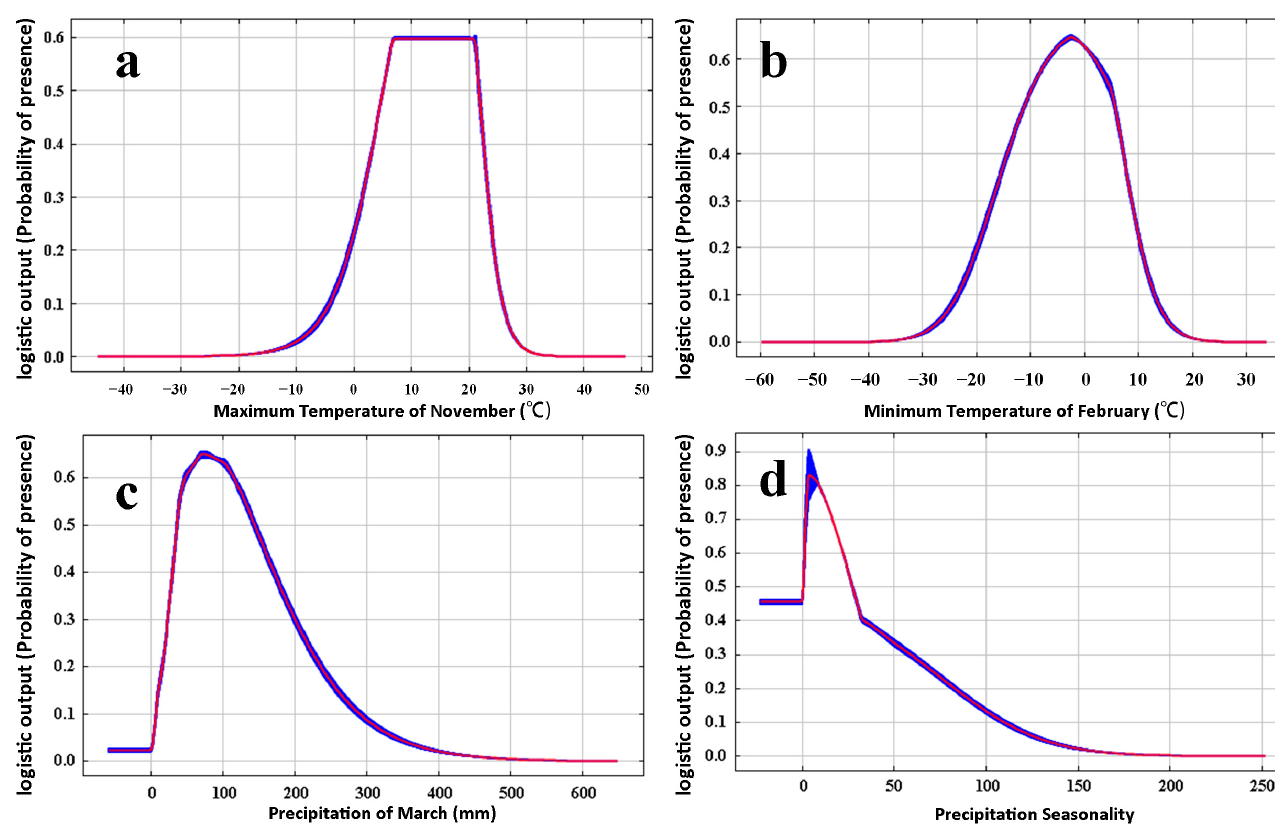
Figure 5. Response curves of M . destructor to various environmental factors in the MaxEnt model. ( a ) Maximum temperature of November (tmax-11), ( b ) minimum temperature of February (tmin-2), ( c ) precipitation of March (prec-3), ( d ) precipitation seasonality (bio-15). Red curves show the mean response and blue margins are ± SD calculated over 10 replicates.